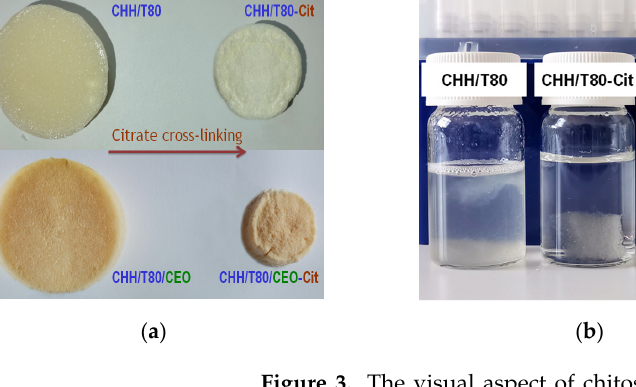
Figure 3. The visual aspect of chitosan-based xerogels, dried ( a ) and immersed in pH 3.6 HCl solution ( b ) or in 10% aqueous acetic acid ( c ).